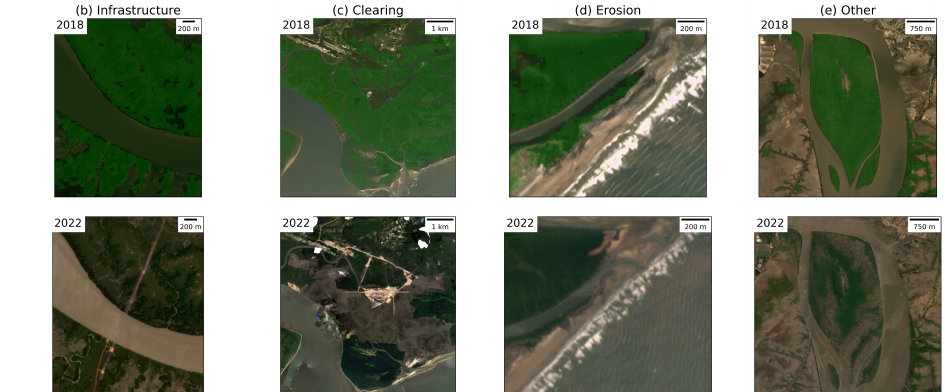
Figure 6. Examples from within the NICFI Planet mosaics of mangrove losses associated with ( a ) agriculture, ( b ) infrastructure, ( c ) clearing, ( d ) erosion and ( e ) ‘other’. The green transparent areas within the first row illustrate the filtered GMW 2018 mangrove extent. (Image courtesy: Planet